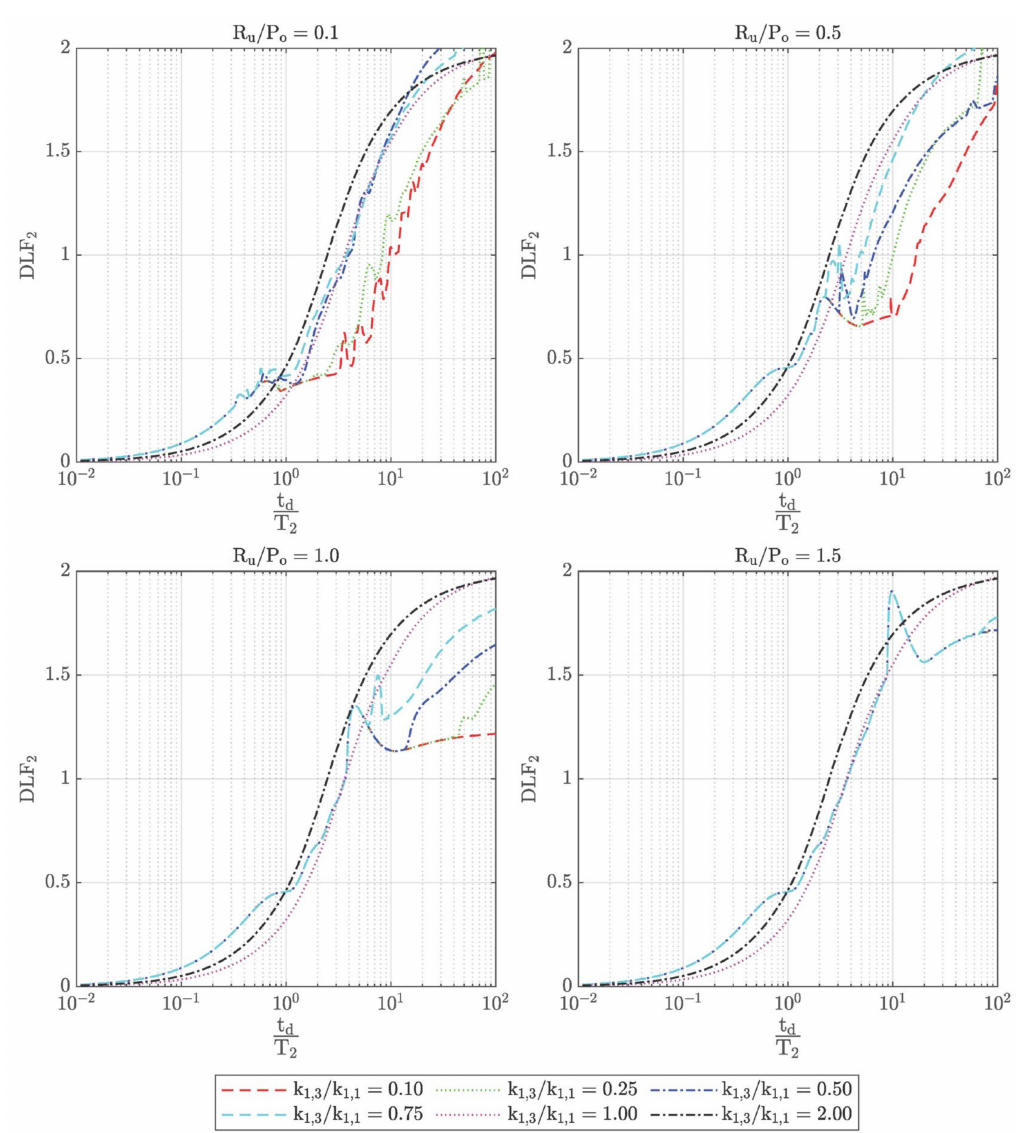
Figure 6. DLF 2 of supporting structure for mass ratio m 2 / m 1 = 0.1, bending stiffness ratio k 2 / k 1,1 = 10.0, and various membrane stiffness ratios ( k 1,3 / k 1,1 = 0.10, 0.25, 0.50, 0.75, 1.00, 2.00) at resistance ratios R u /P o = 0.1, 0.5, 1.0,